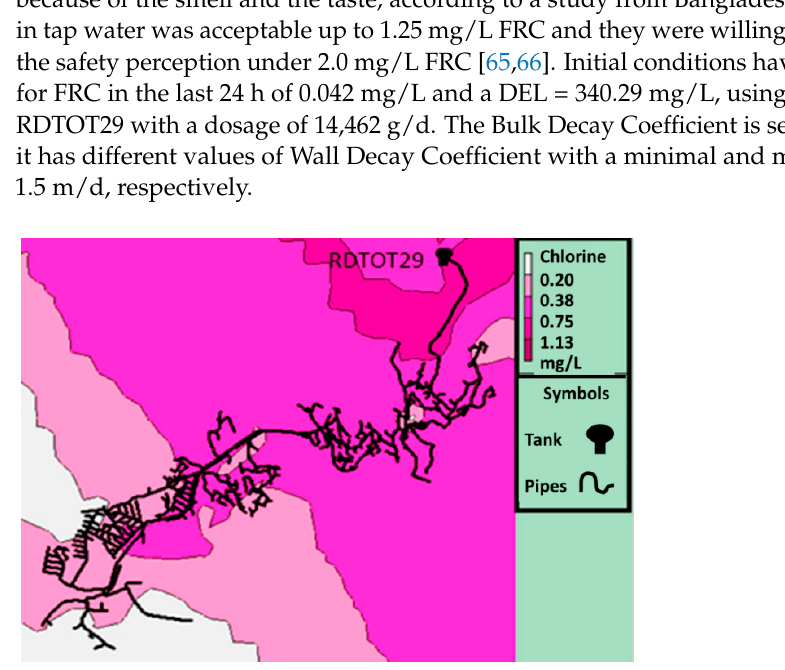
Figure 4. Contour plot of chlorine distribution in the initial condition from WDN